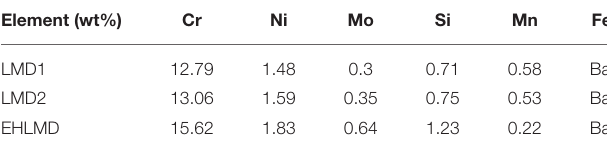
TABLE 3 | Chemical composition of different areas of the two kinds of layers. Element